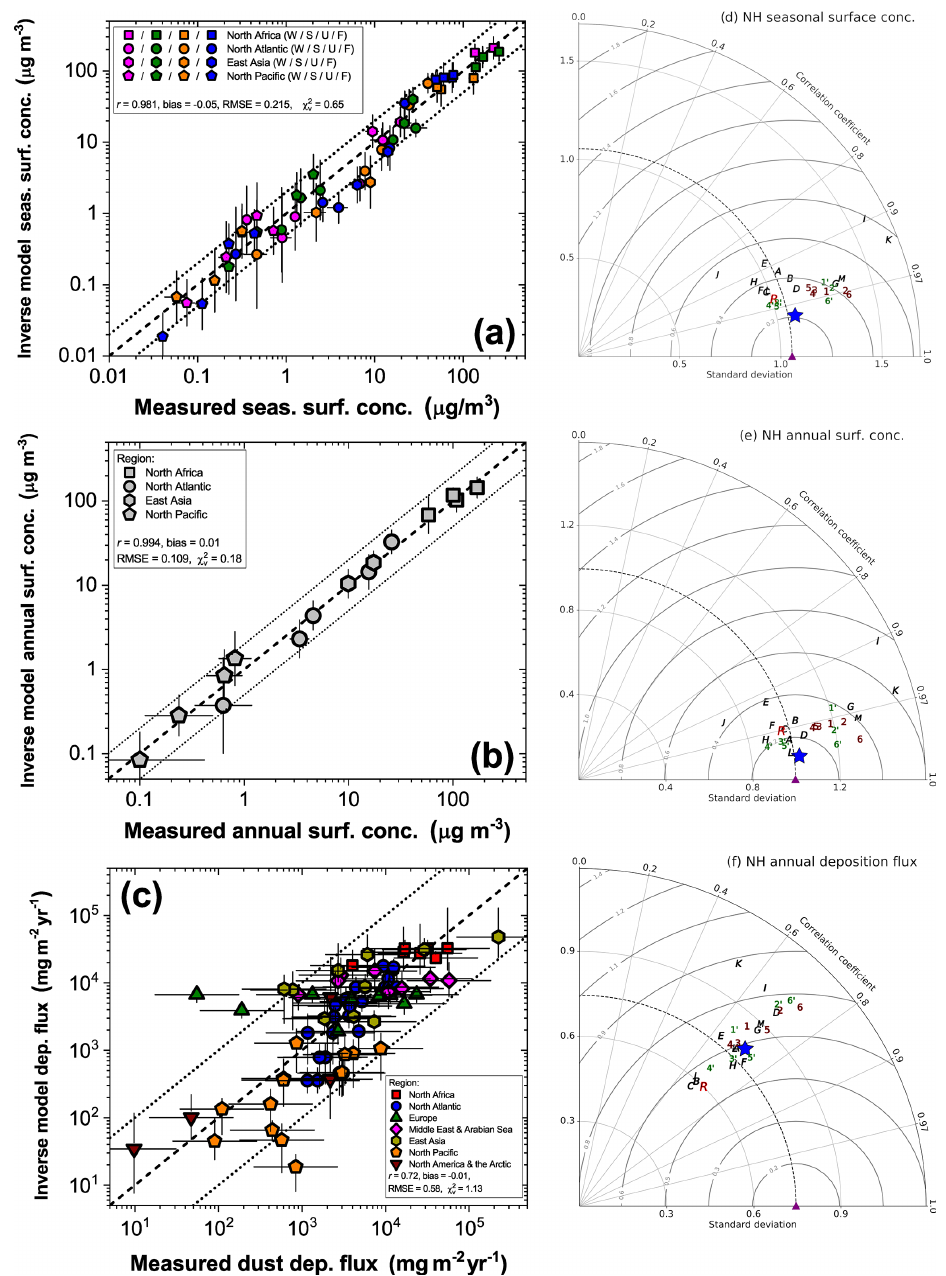
Figure 7. Evaluation of the inverse model results against independent measurements of surface concentration and deposition flux in the Northern Hemisphere. Shown are comparisons of inverse model results against (a) seasonally averaged (winter, spring, summer, and fall are respectively denoted by magenta, green, orange, and blue) and (b) annually averaged dust surface concentration measurements at 15 NH stations and against (c) a compilation of 77 measurements of the dust deposition flux. Results are grouped by regions as shown in Fig. 2. Statistics of the comparisons are noted in the figures and are calculated in log space because the measurements span several orders of magnitude. Uncertainties in inverse model results and measurements represent 1 standard error and are calculated as described in Sects. 2.5 and 3.1, respectively. Also shown are Taylor diagrams summarizing the statistics of the ability of the different models to reproduce the spatial variability in the measured fields of (d) seasonal and (e) annual surface concentration and (f) dust deposition flux (Taylor diagrams do not capture biases between model predictions and observations). The different symbols represent the measurements (purple triangle), the 13 AeroCom models (black letters), MERRA-2 (red R ), the six models in the model ensemble (brown numbers), the six improved models (green numbers with prime), and the inverse model results (large blue star). An exact legend for the different models is provided in Fig.